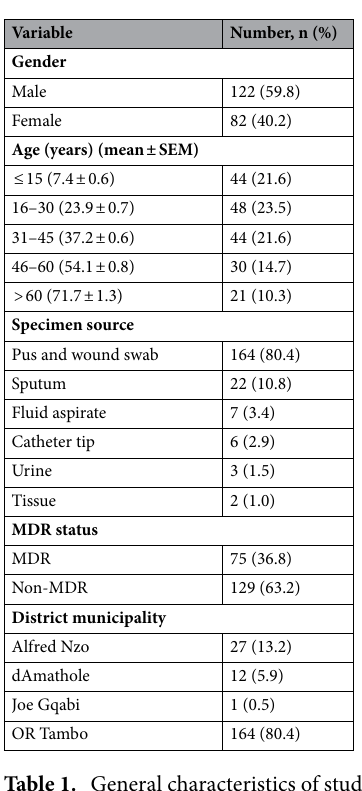
Table 1. General characteristics of study population.